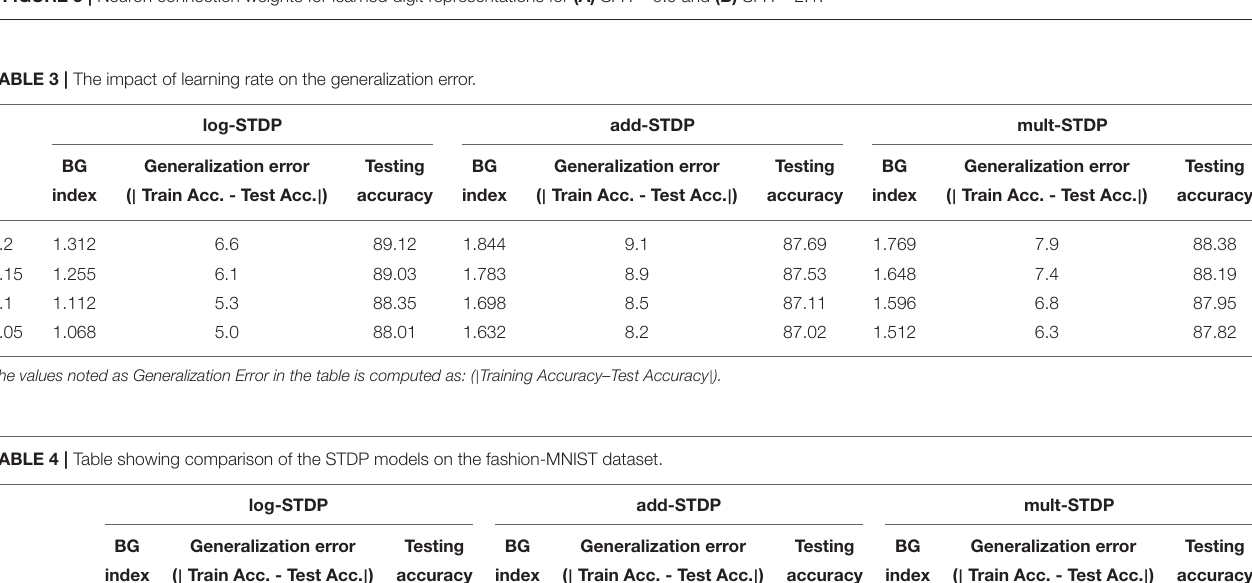
Training Accuracy–Test Accuracy |